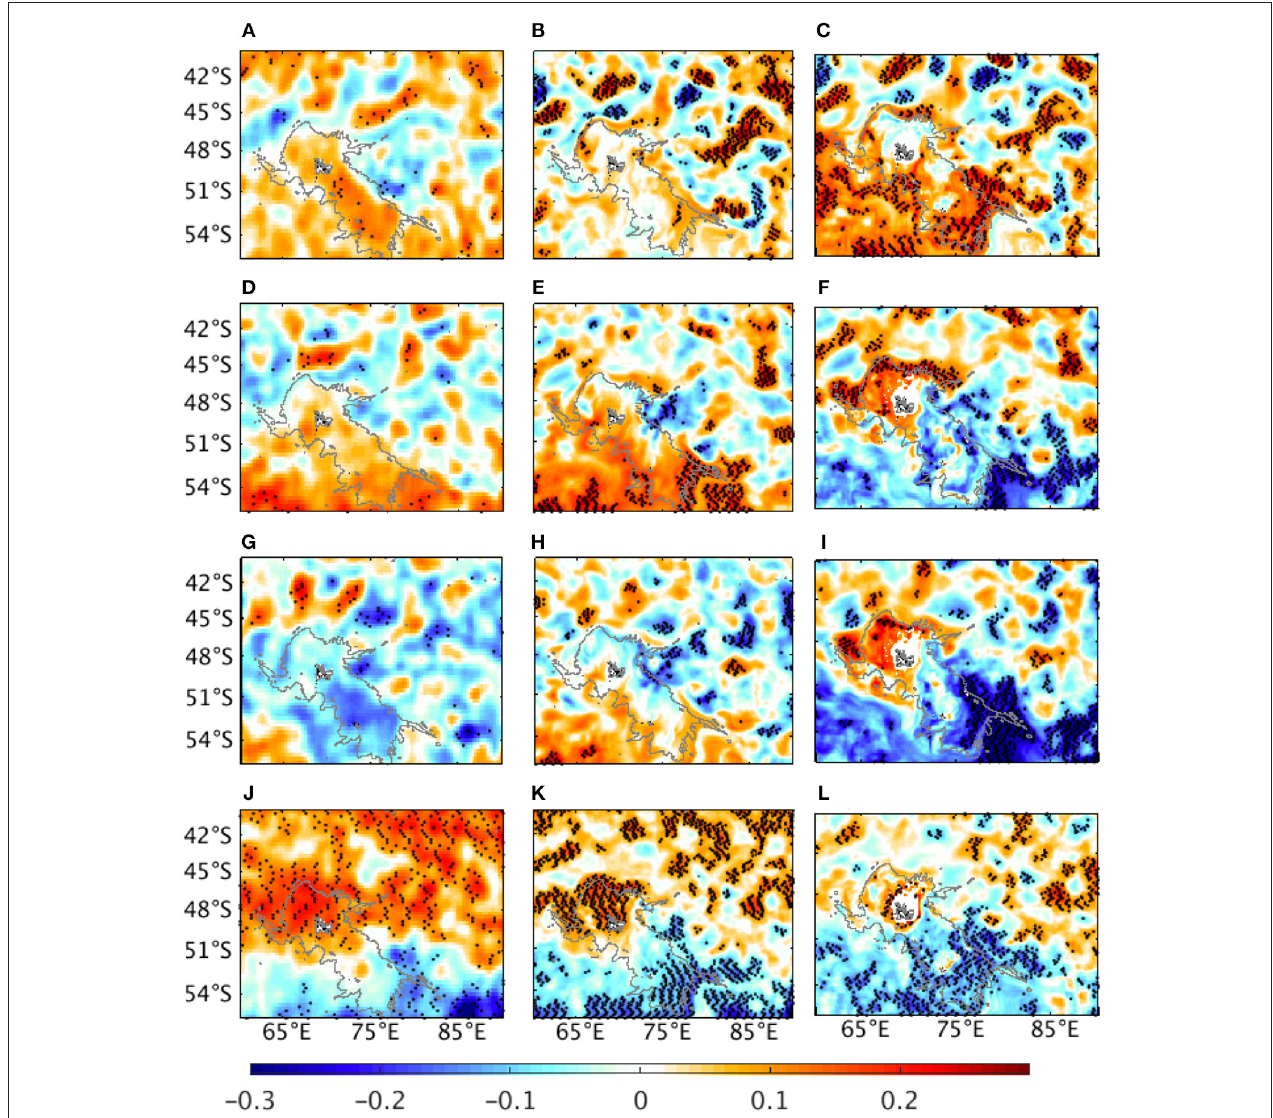
FIGURE 7 | Maps of point-wise correlation coefficients between SST from NOAA-OI (left), temperature at the surface in OFAM (center), and temperature at 150 m in OFAM (right) and indices (single time series) of the following climate modes: (A–C) IOD, (D–F) ENSO, (G–I) PDO, and (J–L) SAM, between Jan 1994 and Dec 2016; the stippling (black dots) indicates regions where the correlations are statistically significant at the 95% confidence level, taking account of the effective number of degrees of freedom; the gray line indicates the 3,000 m